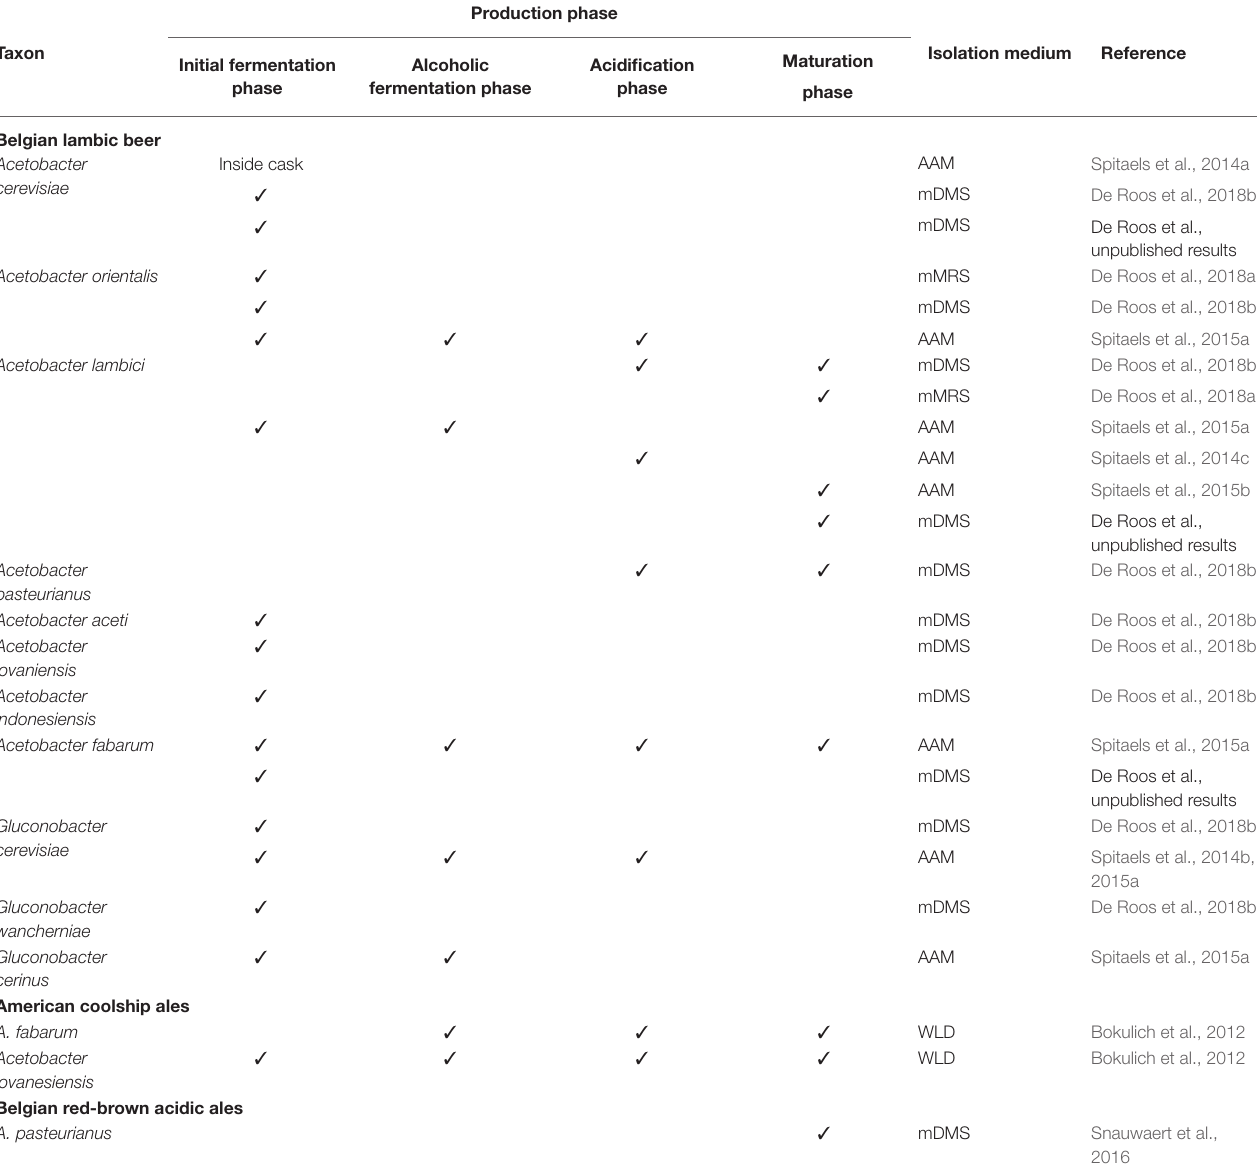
TABLE 1 | Overview of acetic acid bacterial species identified culture-dependently from sour